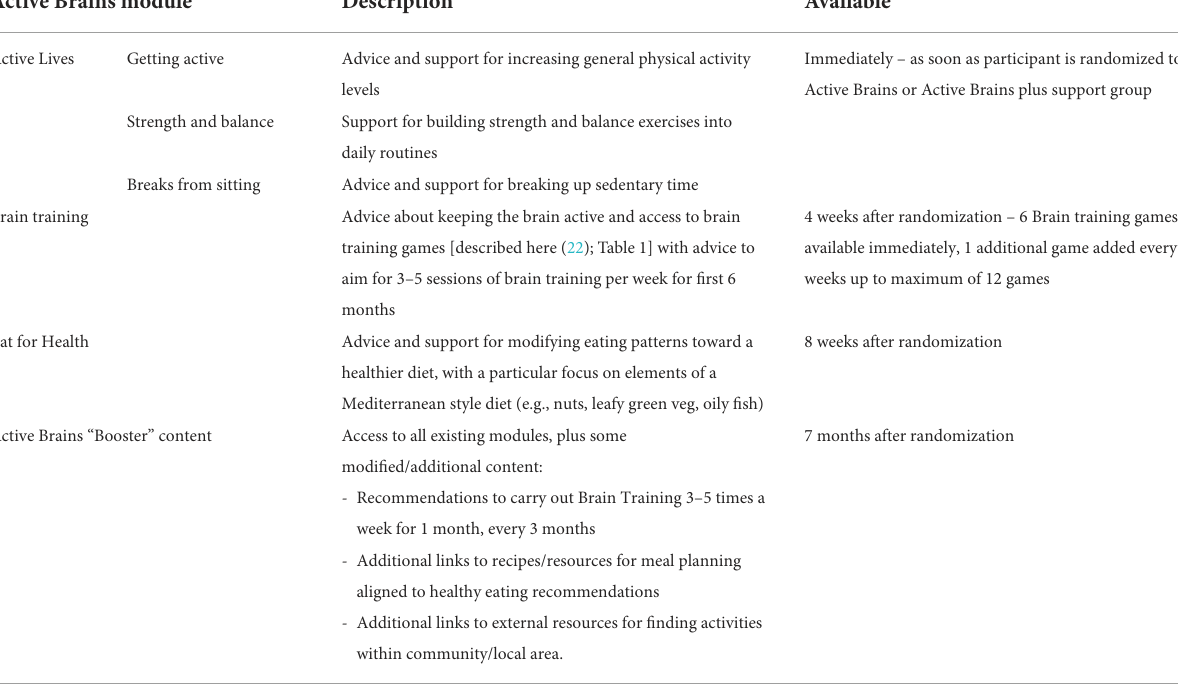
TABLE 2 Active Brains modules and release schedule.